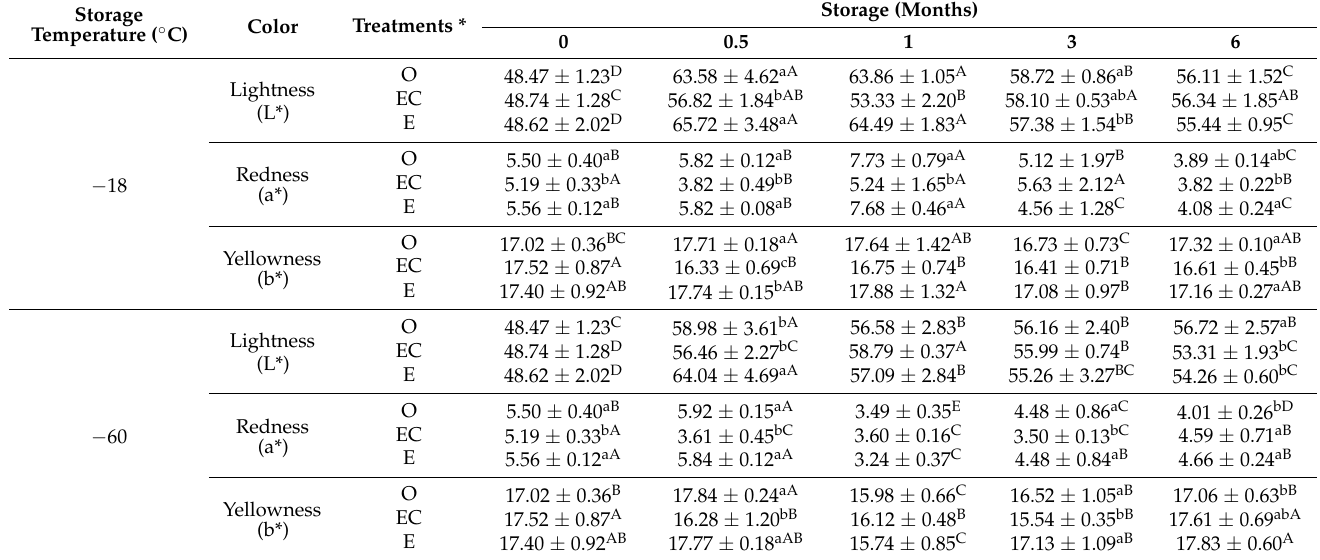
Table 2. Color of meat analogs with different fat replacers (O, EC, and E) during the freezing storage ( − 18 ◦ C, − 60 ◦ C) for six